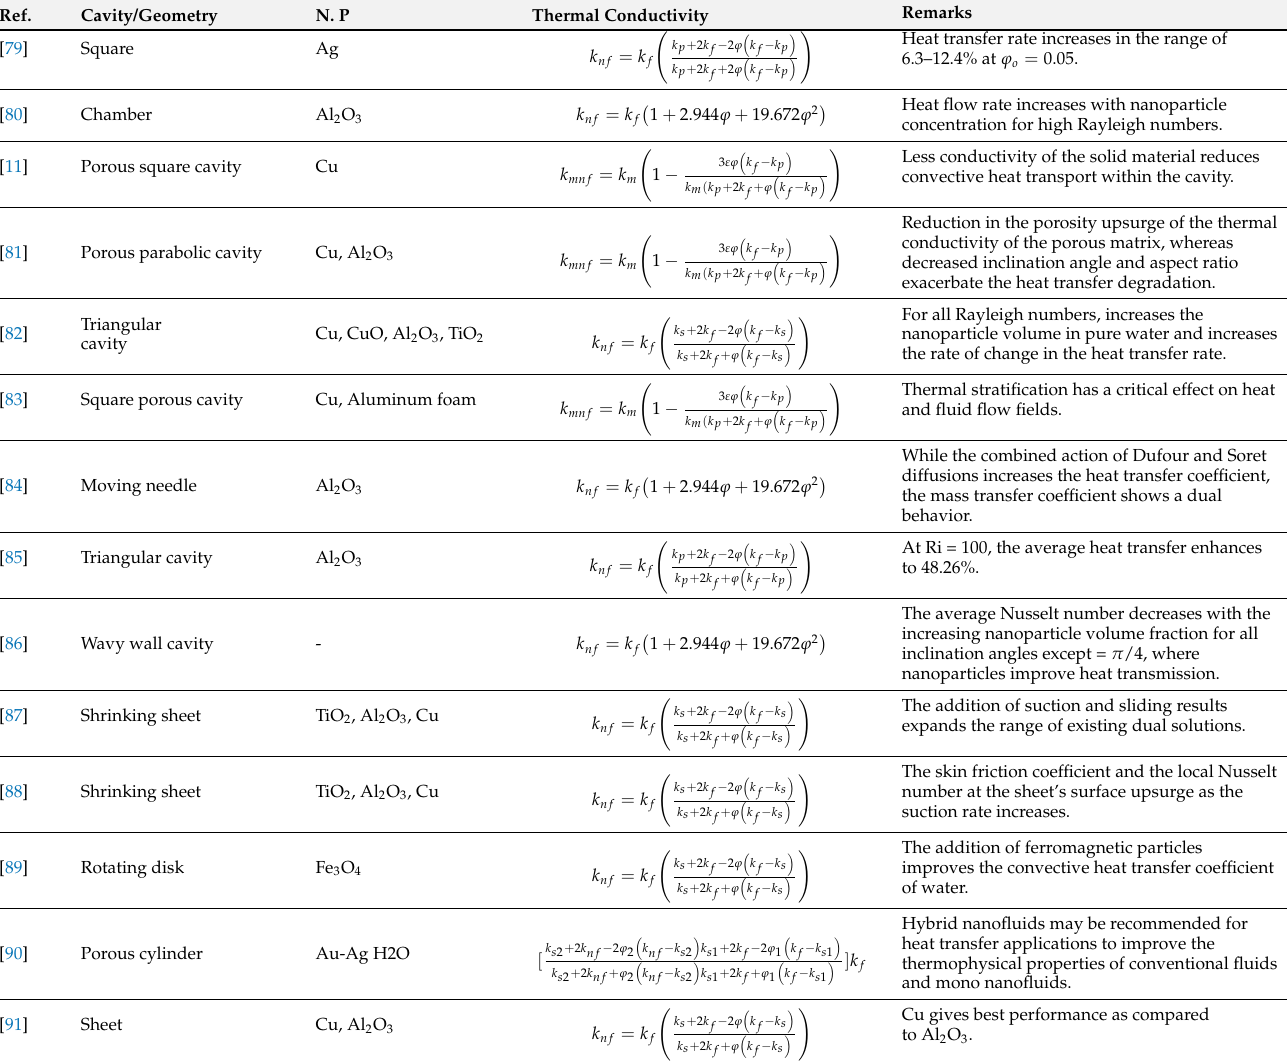
Table 3. Different thermal conductivity correlations used by researchers using the Tiwari and Das model for various